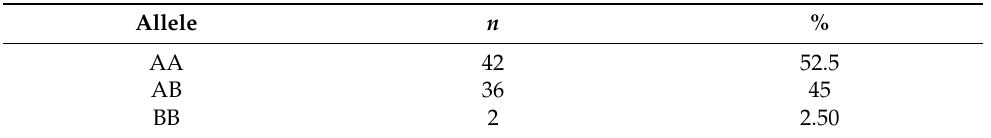
Table 1. PaLAR3 allele distribution among 80 Finnish Norway spruce ( Picea abies ) plus-trees used for SE-initiations from 2011 to 2019 in Finland.